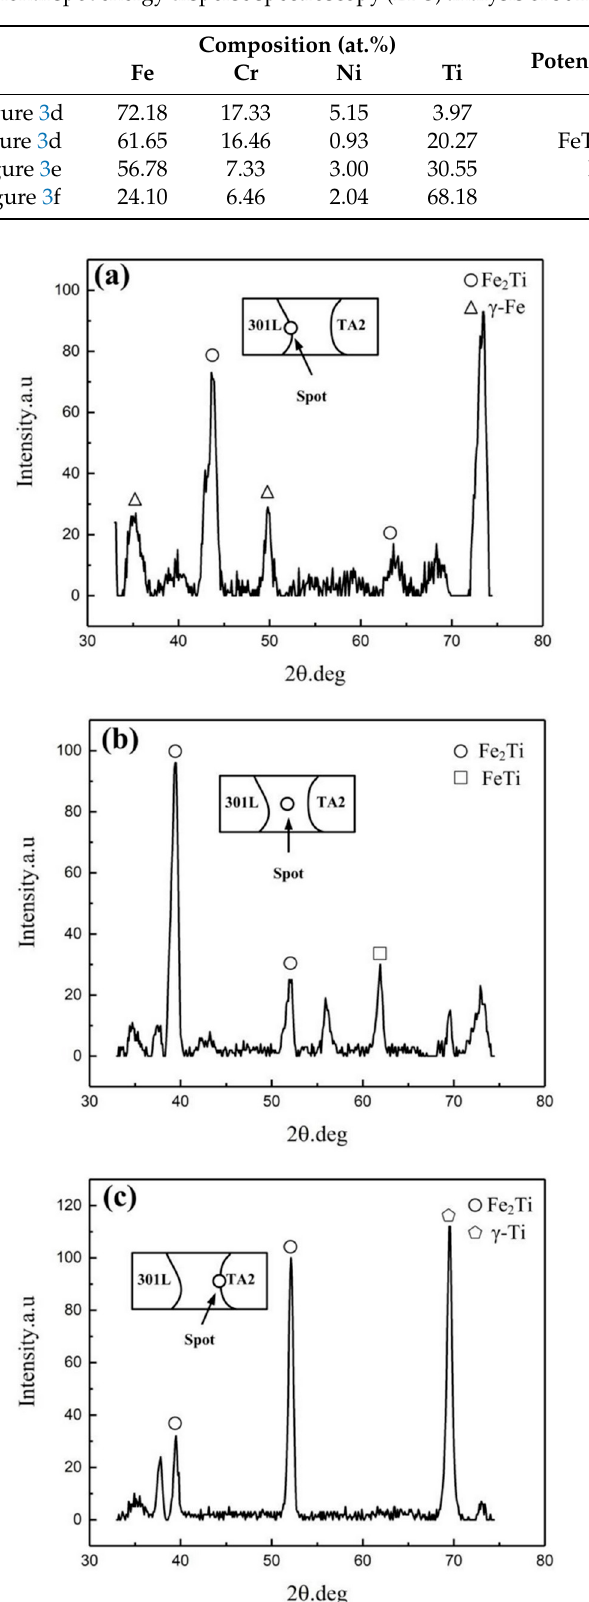
Figure 4. Micro-XRD analysis results of 301L / TA2 welded joints: ( a ) 301L side; ( b ) welding center; ( c ) TA2 side.